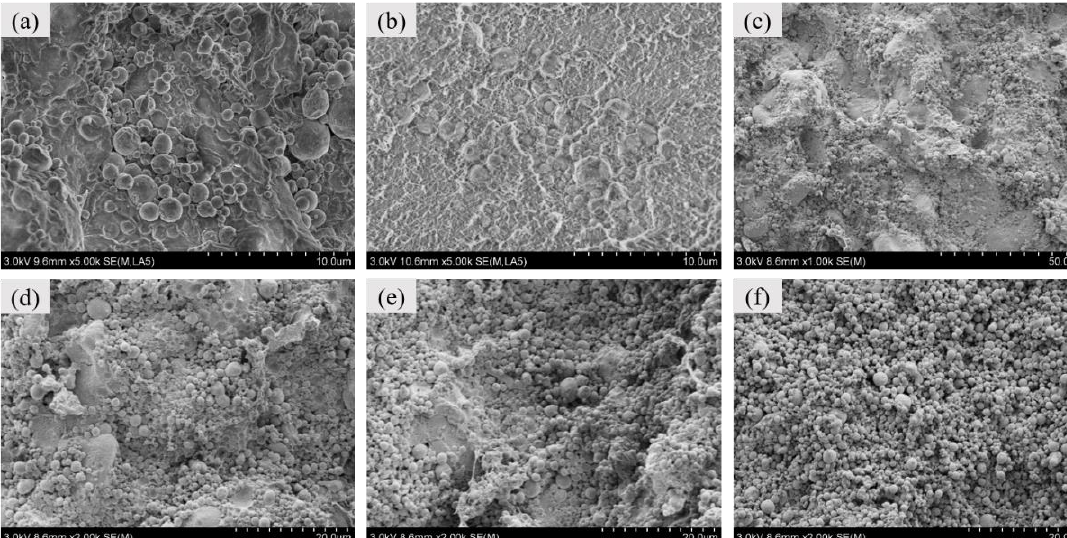
Figure 3. The interior microstructures of the specimens: ( a ) The type A specimen before sintering; ( b ) the type A specimen after sintering (local); ( c ) the type A specimen after sintering (overall); ( d ) the type B specimen after sintering; ( e ) the type C specimen after sintering; ( f ) the type F specimen after sintering.